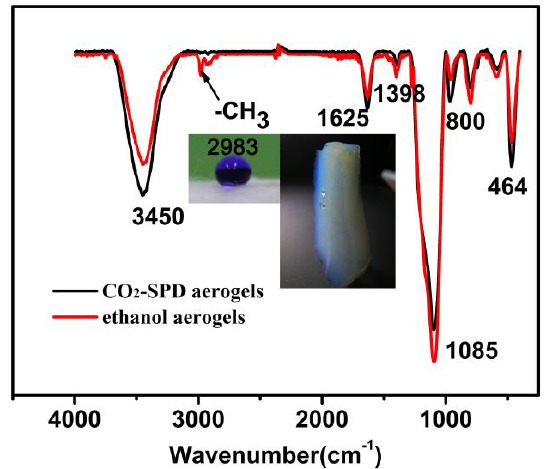
Figure 1. FT-IR spectra of the CO 2 -SPD and ethanol-SPD aerogels. Insets are the photographs of a